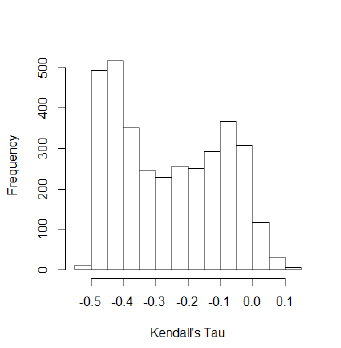
Figure 6: Correlation between distance and cosine similarity for all Tweet